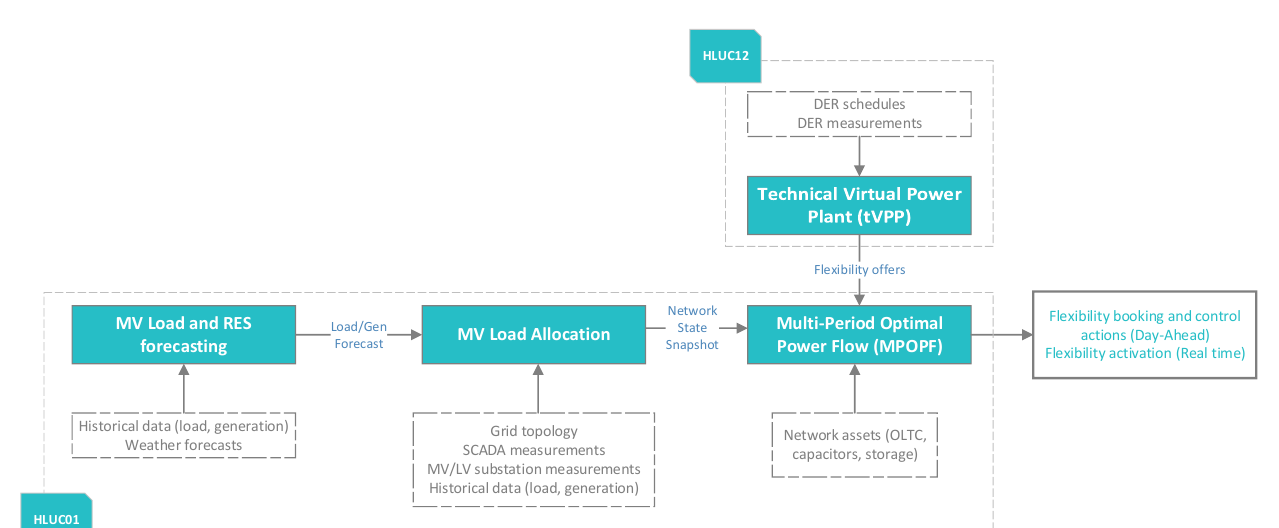
Figure 4. Cluster 01. Global